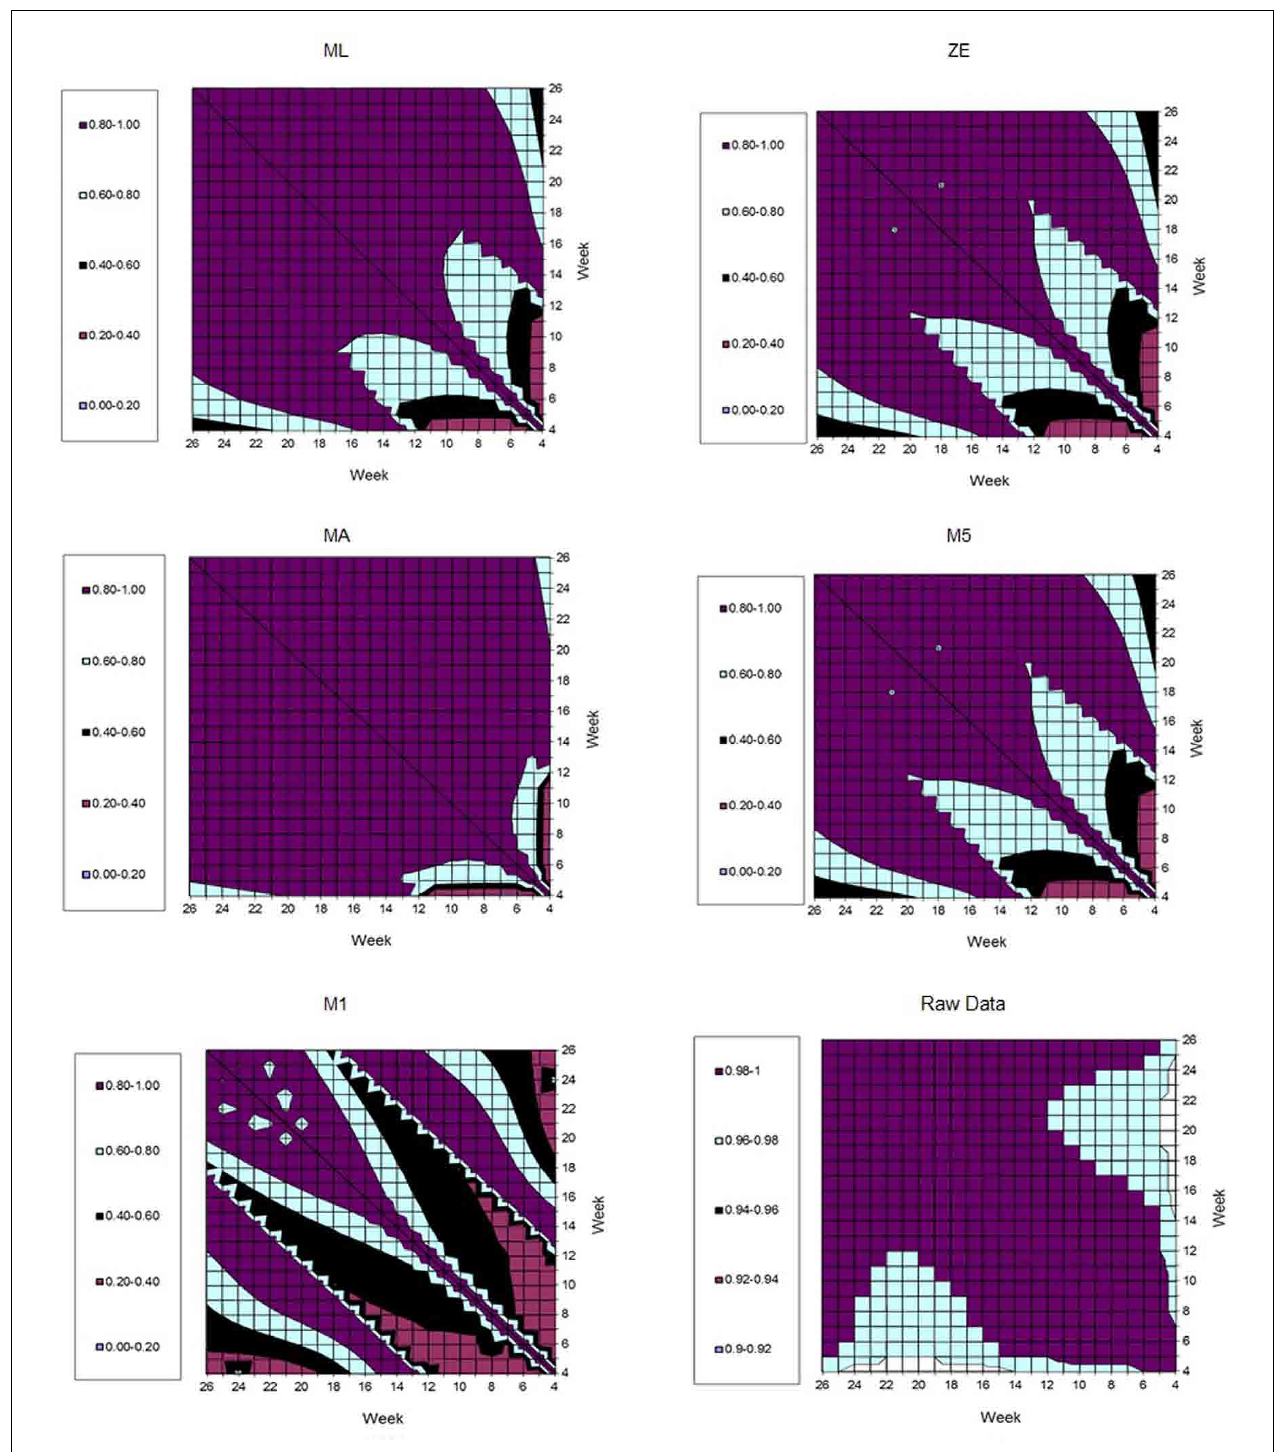
FIGURE 7 | Estimates of genetic correlation among fecal egg count (FEC) weekly measures, according different kinds of transformations ( λ values).